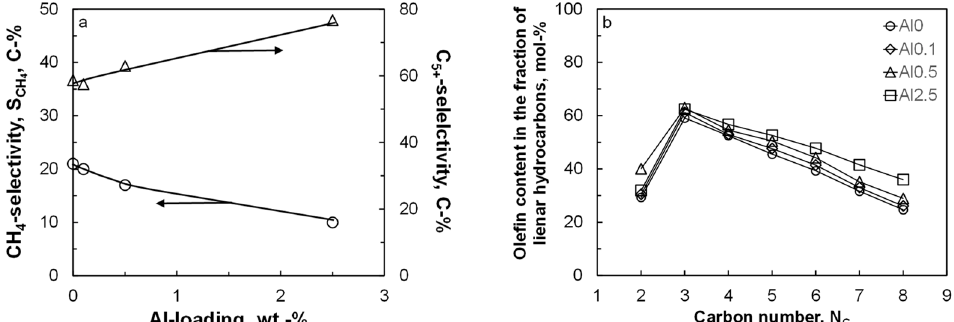
Figure 2. Selectivity for methane and C 5 + as a function of the aluminum content ( a ) and the olefin content in the fraction of linear hydrocarbons as a function of carbon number ( b ) in the Fischer–Tropsch synthesis (220 ◦ C, 20 bar feed; H 2 :CO:Ar = 2:1:1; X CO = 14.5 ± 2%).